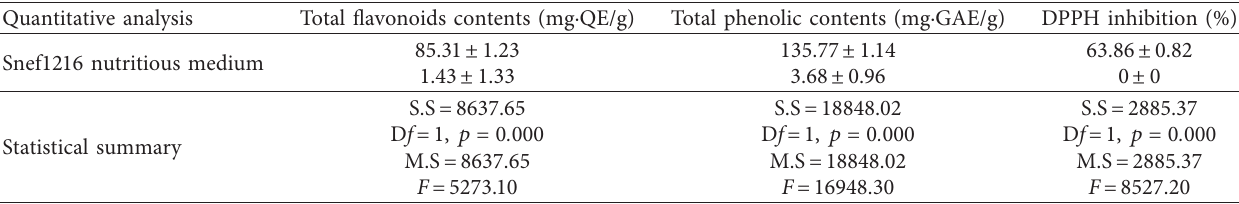
Table 2: Total flavonoids contents, total phenolic contents, and DPPH radical scavenging activity of fermentation of Snef1216 ( P. chrysogenum ) and nutritious medium. Quantitative